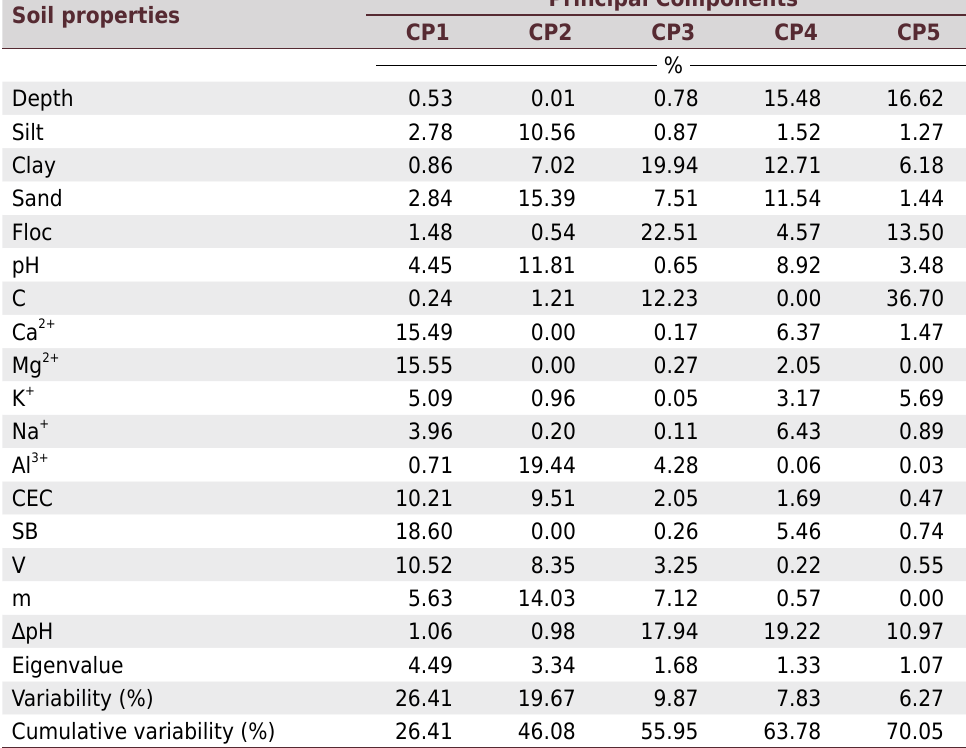
Table 2. Eigenvalue, variability, and percentage explained for the first five principal components selected according to the Kaiser criterion Soil